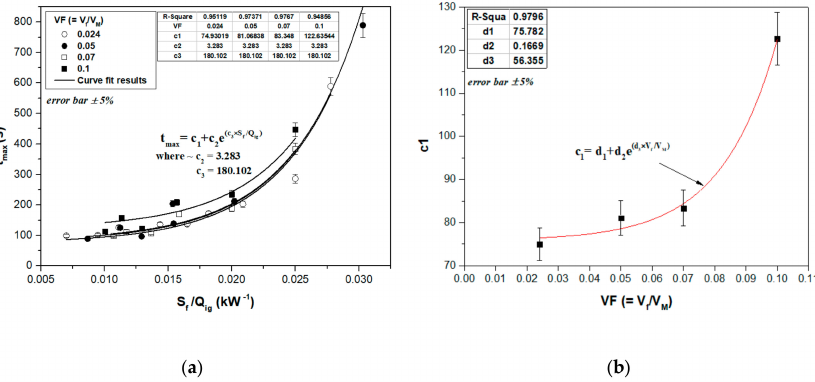
Figure 11. ( a ) Maximum time vs. S f / Q ig for 0.024, 0.05, 0.07, and 0.1 of the volume fraction and ( b ) the curve-fit results of experiment coe ffi cient c1 vs. volume